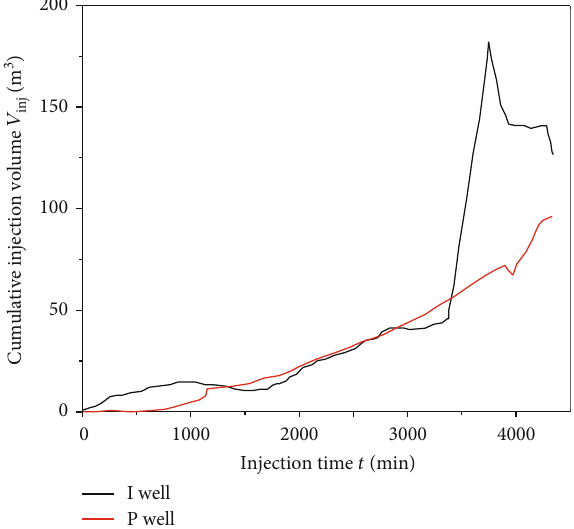
Figure 20: Cumulative injection volume of wellpair A-2.